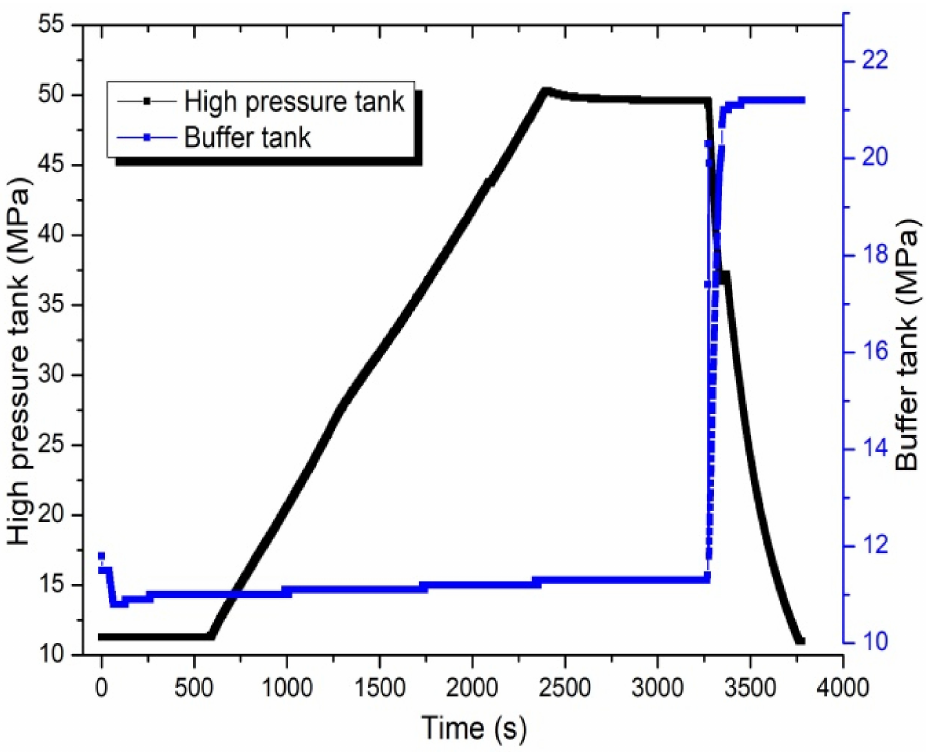
Figure 5. Experimental pressure data of the compressed hydrogen storage tank for the second cycle.